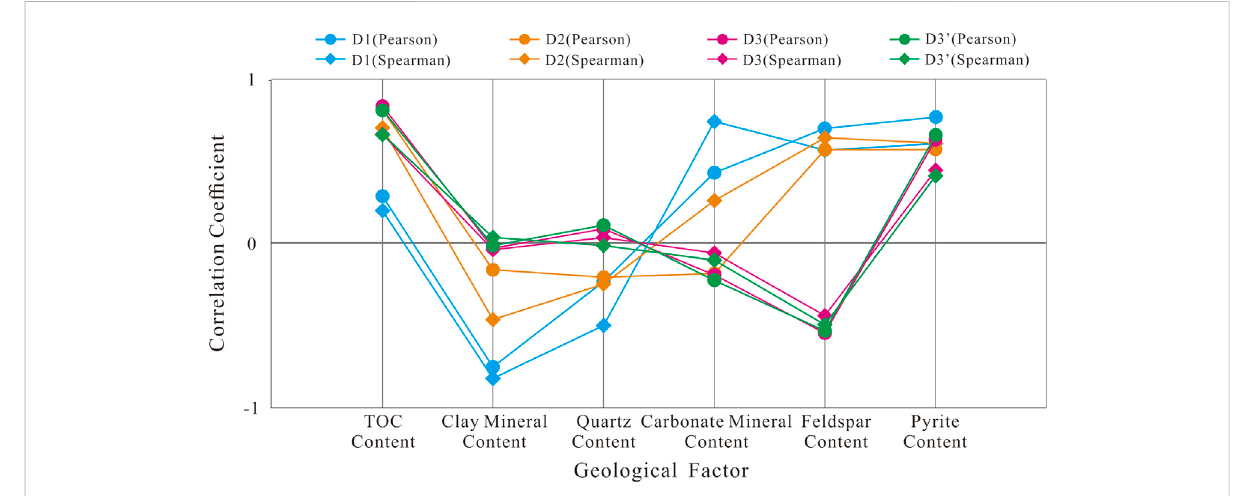
FIGURE 14 Main controlling factors analysis of multi-scale pore fractal dimension.